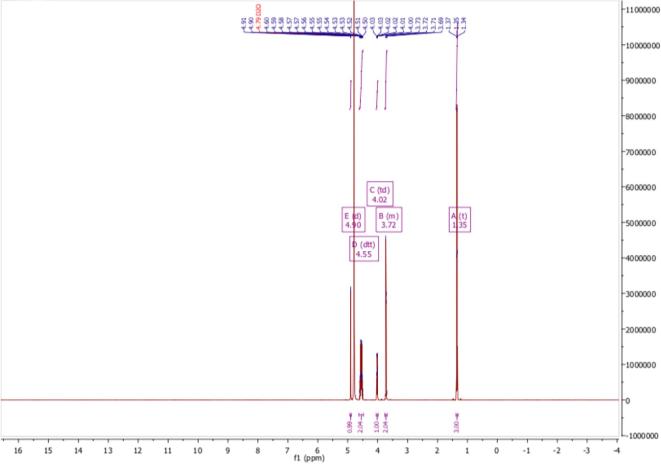
1H NMR spectrum of 3-o-ethyl-l-ascorbic acid in D2O.